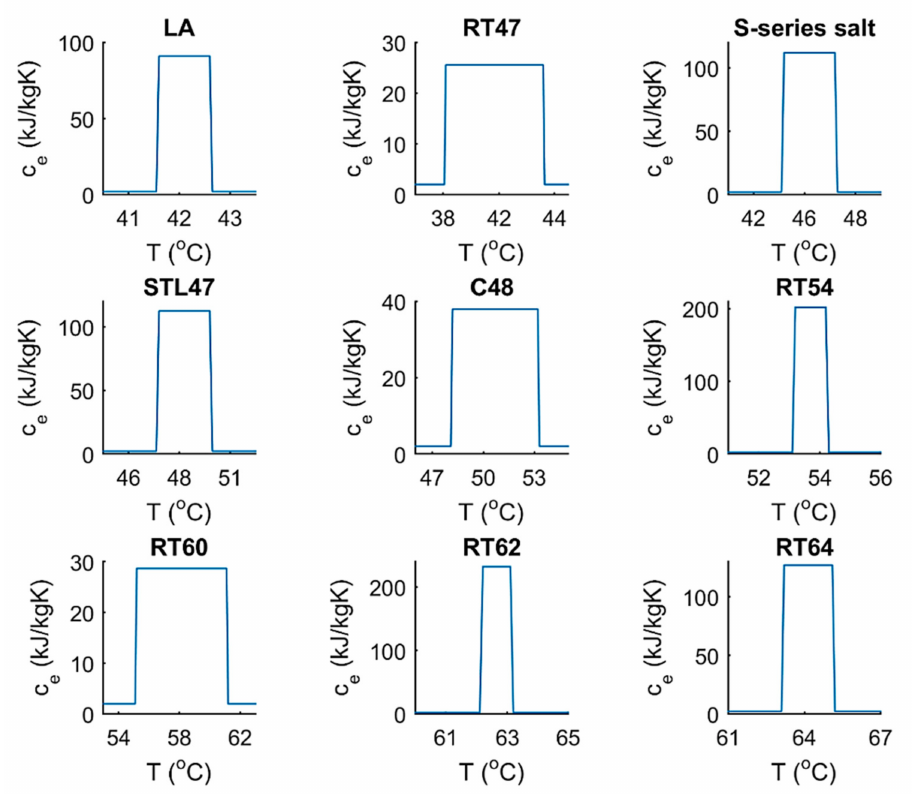
Figure 3. Effective heat capacities of selected phase change materials during phase